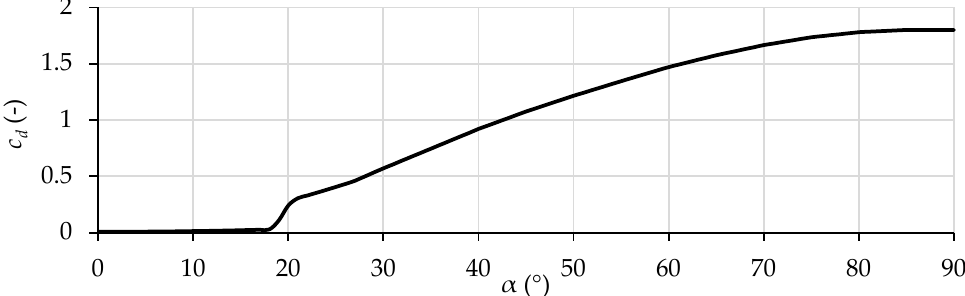
Figure 6. The drag coefficients of the NACA-0015 aerofoil, obtained by iterations of the average Reynolds Number for 𝛼 < 30° and independent of the Reynolds Number for 𝛼 ≥ 30° .